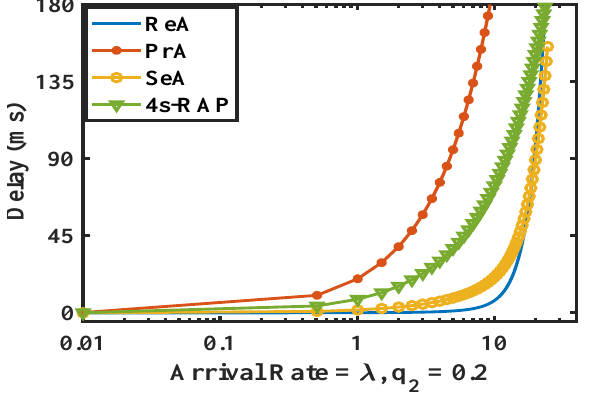
Figure 2. Average delay ( q 2 = 0.2).